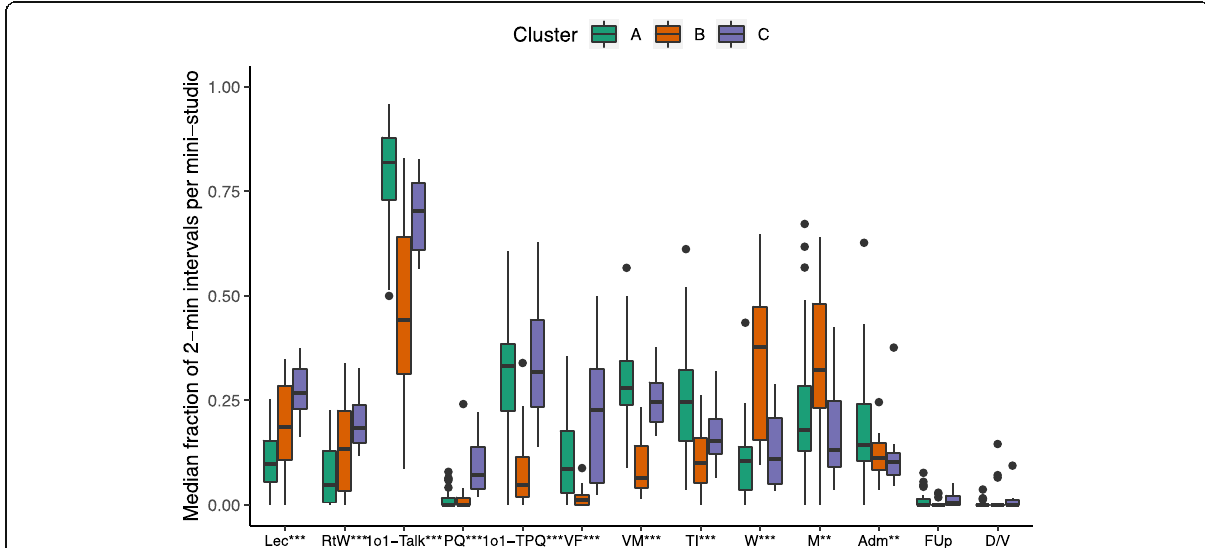
Fig. 6 Median fraction of GTA codes in each cluster in physics mini-studios (combined tutorials and laboratories). Eleven codes are statistically